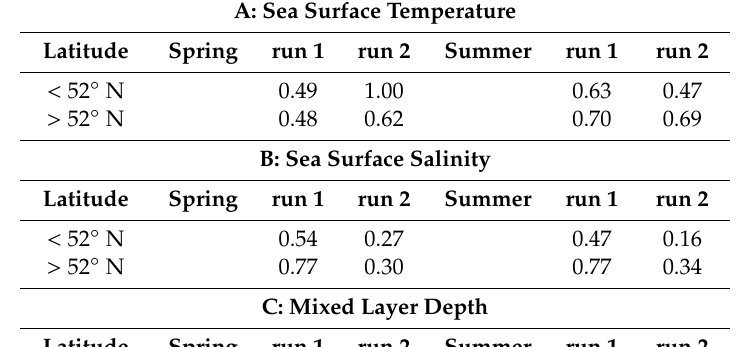
Table 1. Root mean square error (RMSE) of Stratiphyt observations and NEMO-PISCES (nucleus for European modelling of the ocean - pelagic interactions scheme for carbon and ecosystem studies) run 1 and 2 for stations < 52º N (n = 21) and > 52º N (n = 11) for a: Sea surface temperature; b: Sea surface salinity; and c: Mixed layer depth. Spring observations of Stratiphyt (2011) were compared with NEMO -PISCES of spring 2009 run 1 and 2. Summer observations of Stratiphyt (2009) were compared with NEMO-PISCES summer 2009 run 1 and 2.